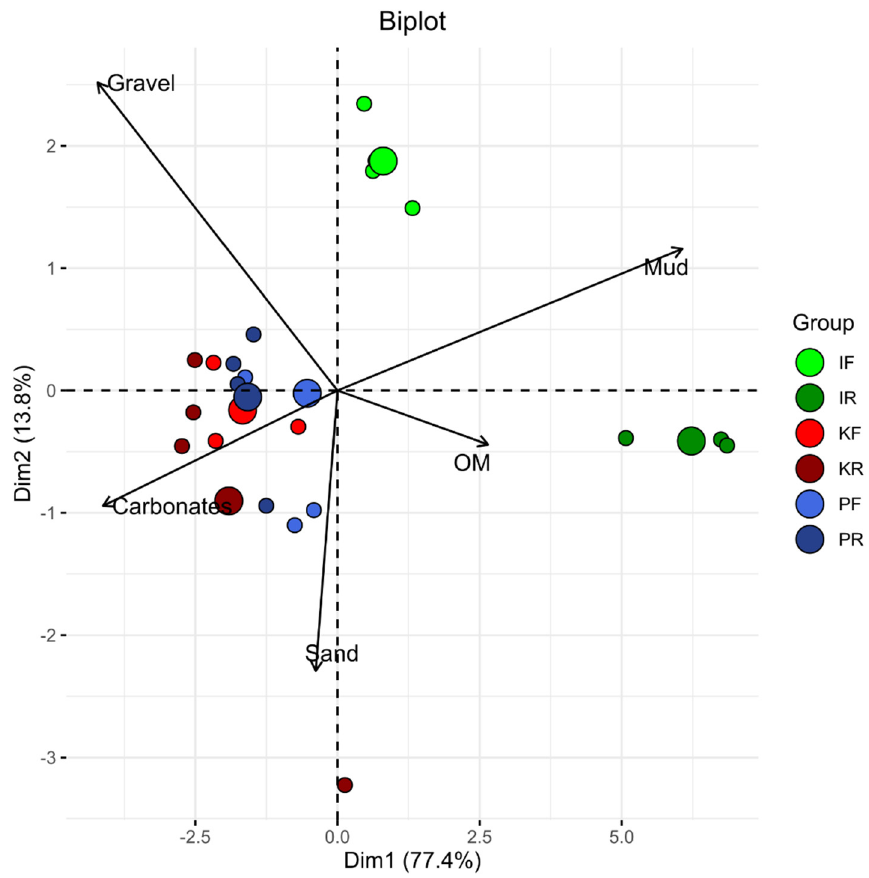
Figure 5. Principal component analysis (PCA) biplot of the first two PCs. The larger circles represent the geometric mean of the data within each group.